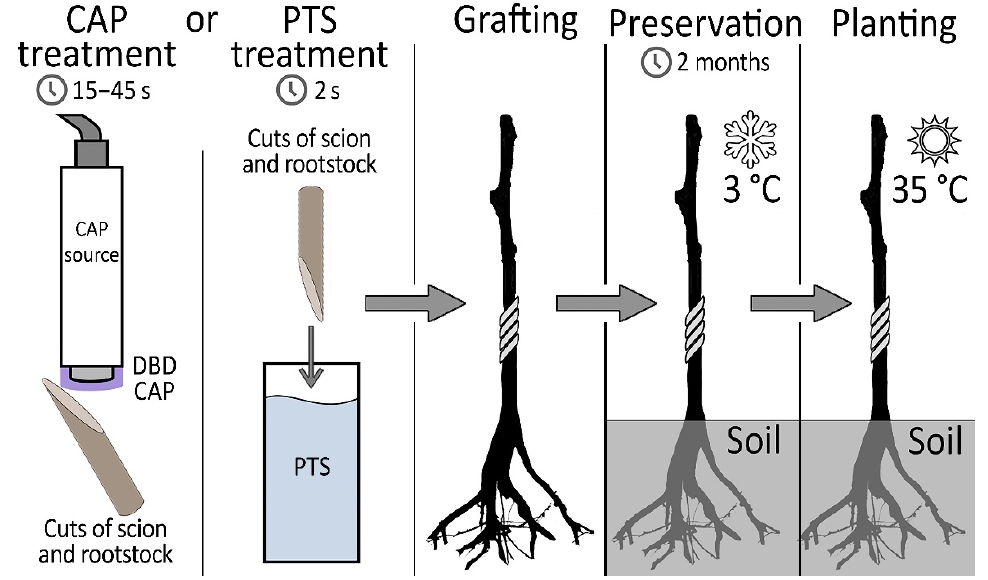
Figure 1. Experimental protocol.